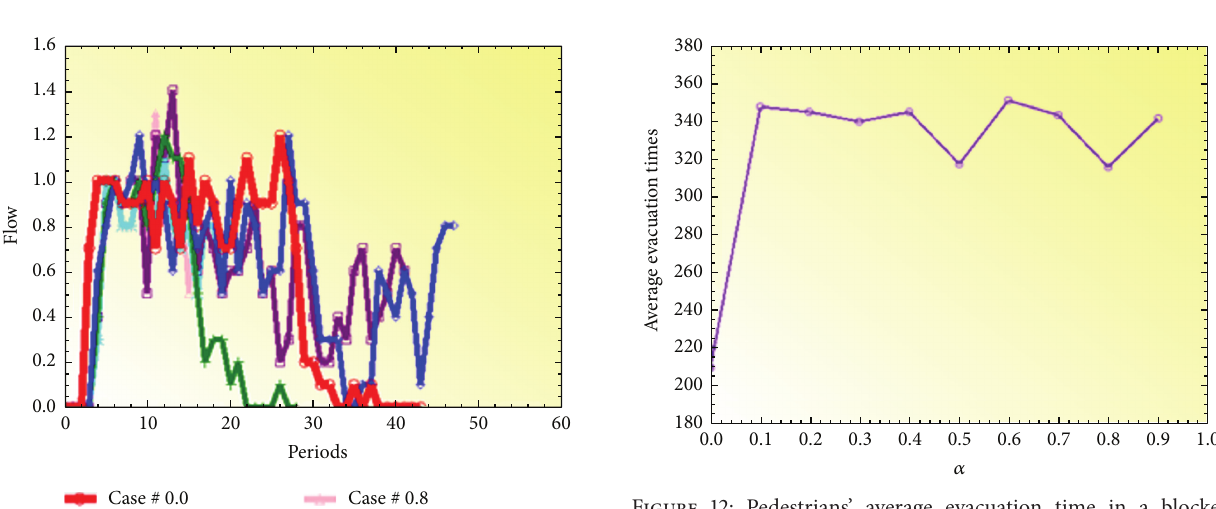
Figure 11: Fundamental diagram in a blocked corridor.